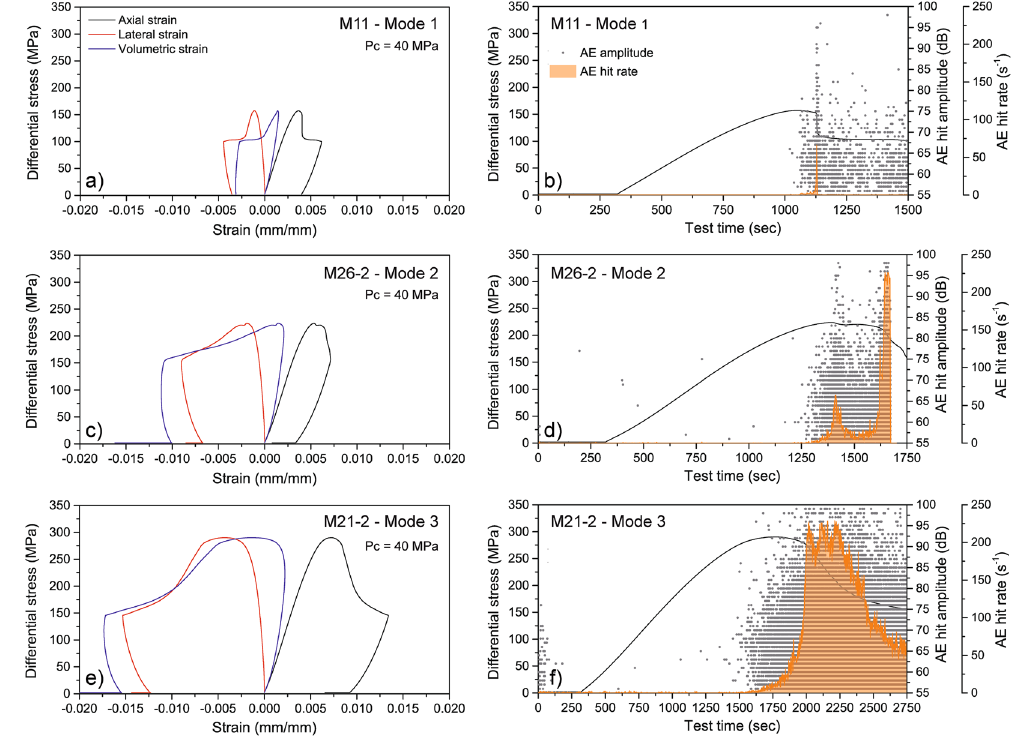
Figure 2. Mechanical and microseismic behaviour of specimens representative of different failure modes. ( a , b , c ) complete stress-strain curves (axial, lateral and volumetric strains); ( d , e , f ) curves of differential stress and acoustic emission (AE) hit rate vs time, and amplitudes of AE hits recorded at different test times. Specimens are the same as in Fig.